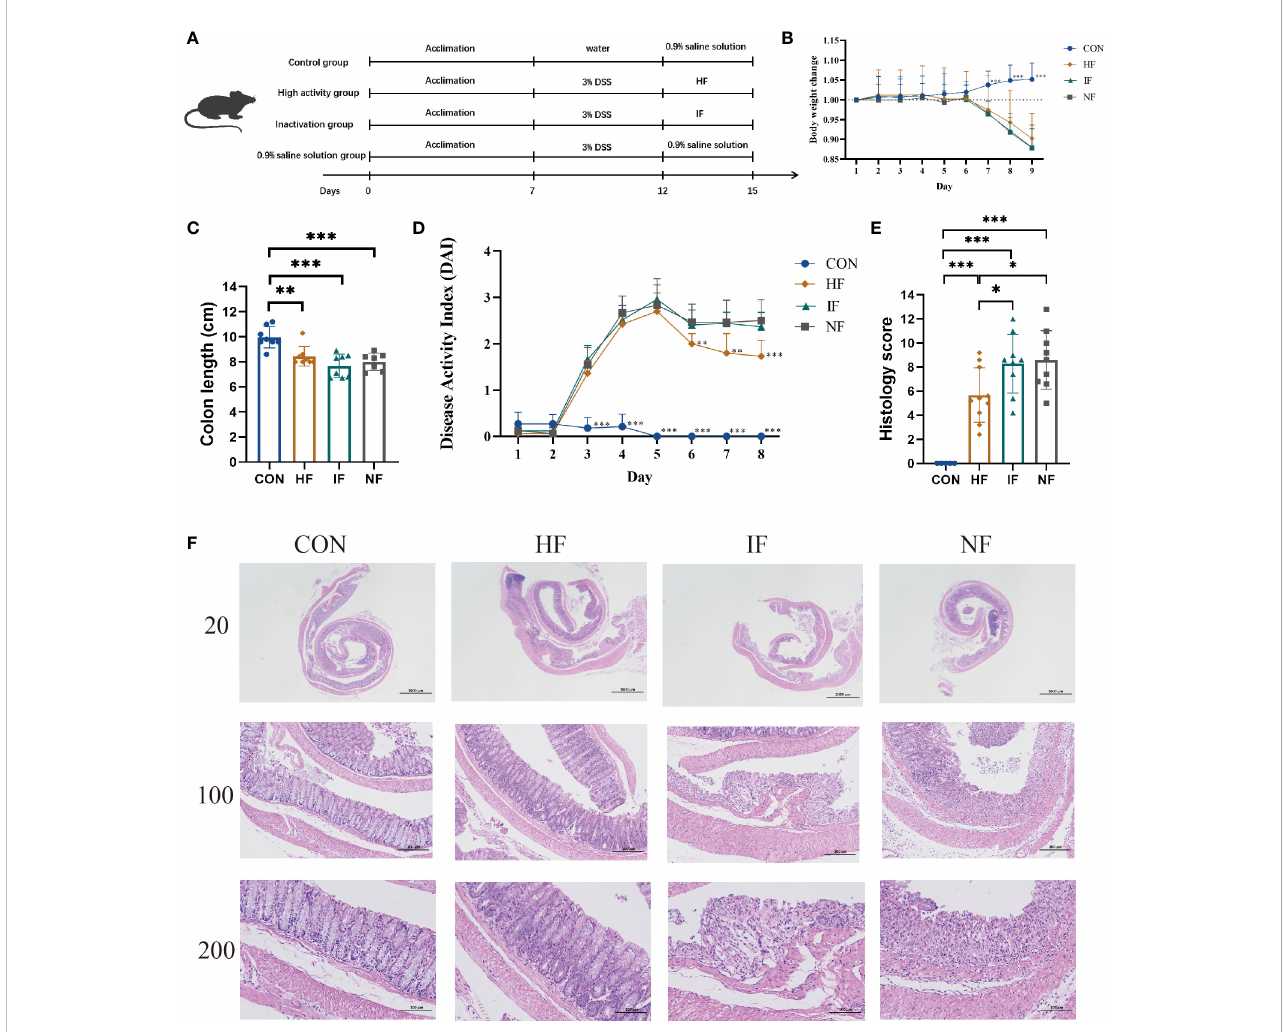
FIGURE 1 (A) The animal experimental protocol. (B) Daily body weight changes throughout the entire duration of the study. (C) the lengths of colon from each group. (D) Kinetics of DAI scores throughout the entire duration of the study. (E) Histological scores of colons. (F) H&E stained colon sections. Data are presented as mean ± SD. ***p < 0.001, **p < 0.01 and *p < 0.05 vs the NF